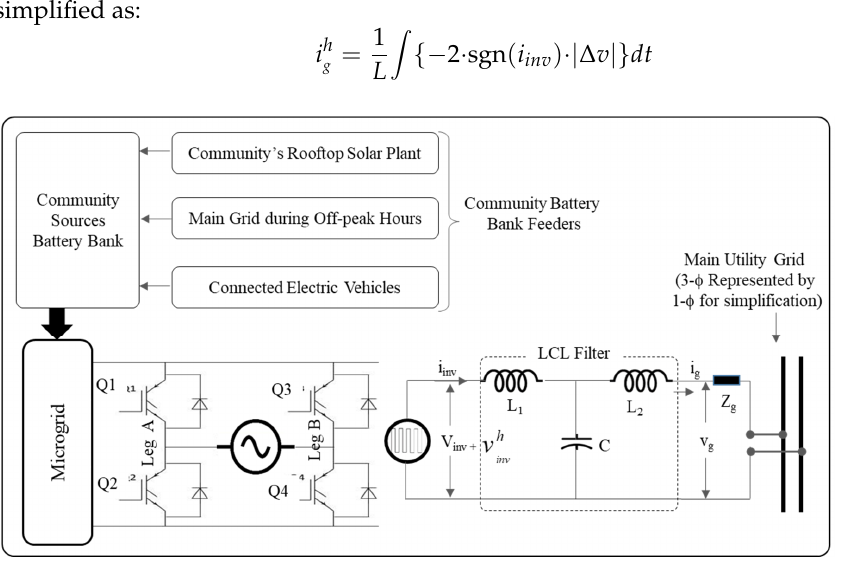
Figure 5. Model of Inverter with Electrical Parameters, Battery Bank Feeders, and Main Grid (Single phase representation of 3Phase AC). v is the fundamental, h v is the distortion in the inverter output voltage, Where 1 inv inv